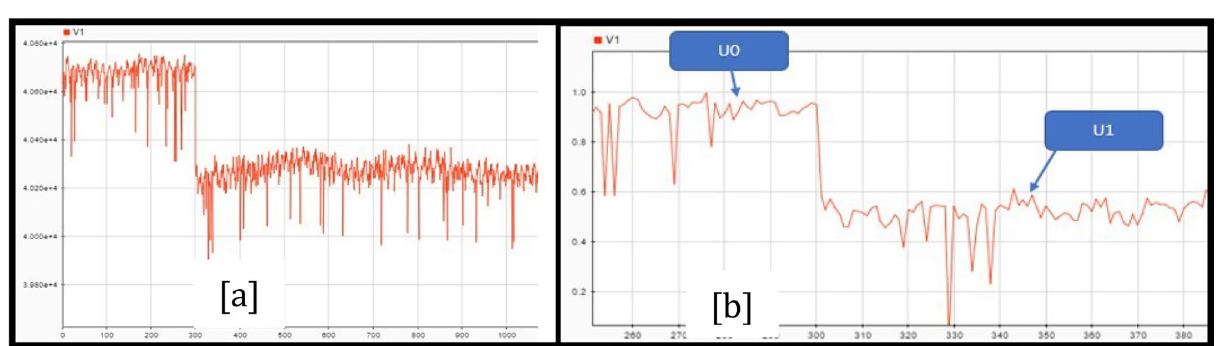
Figure 23. Voltage disturbance ( a ) and point selection ( b